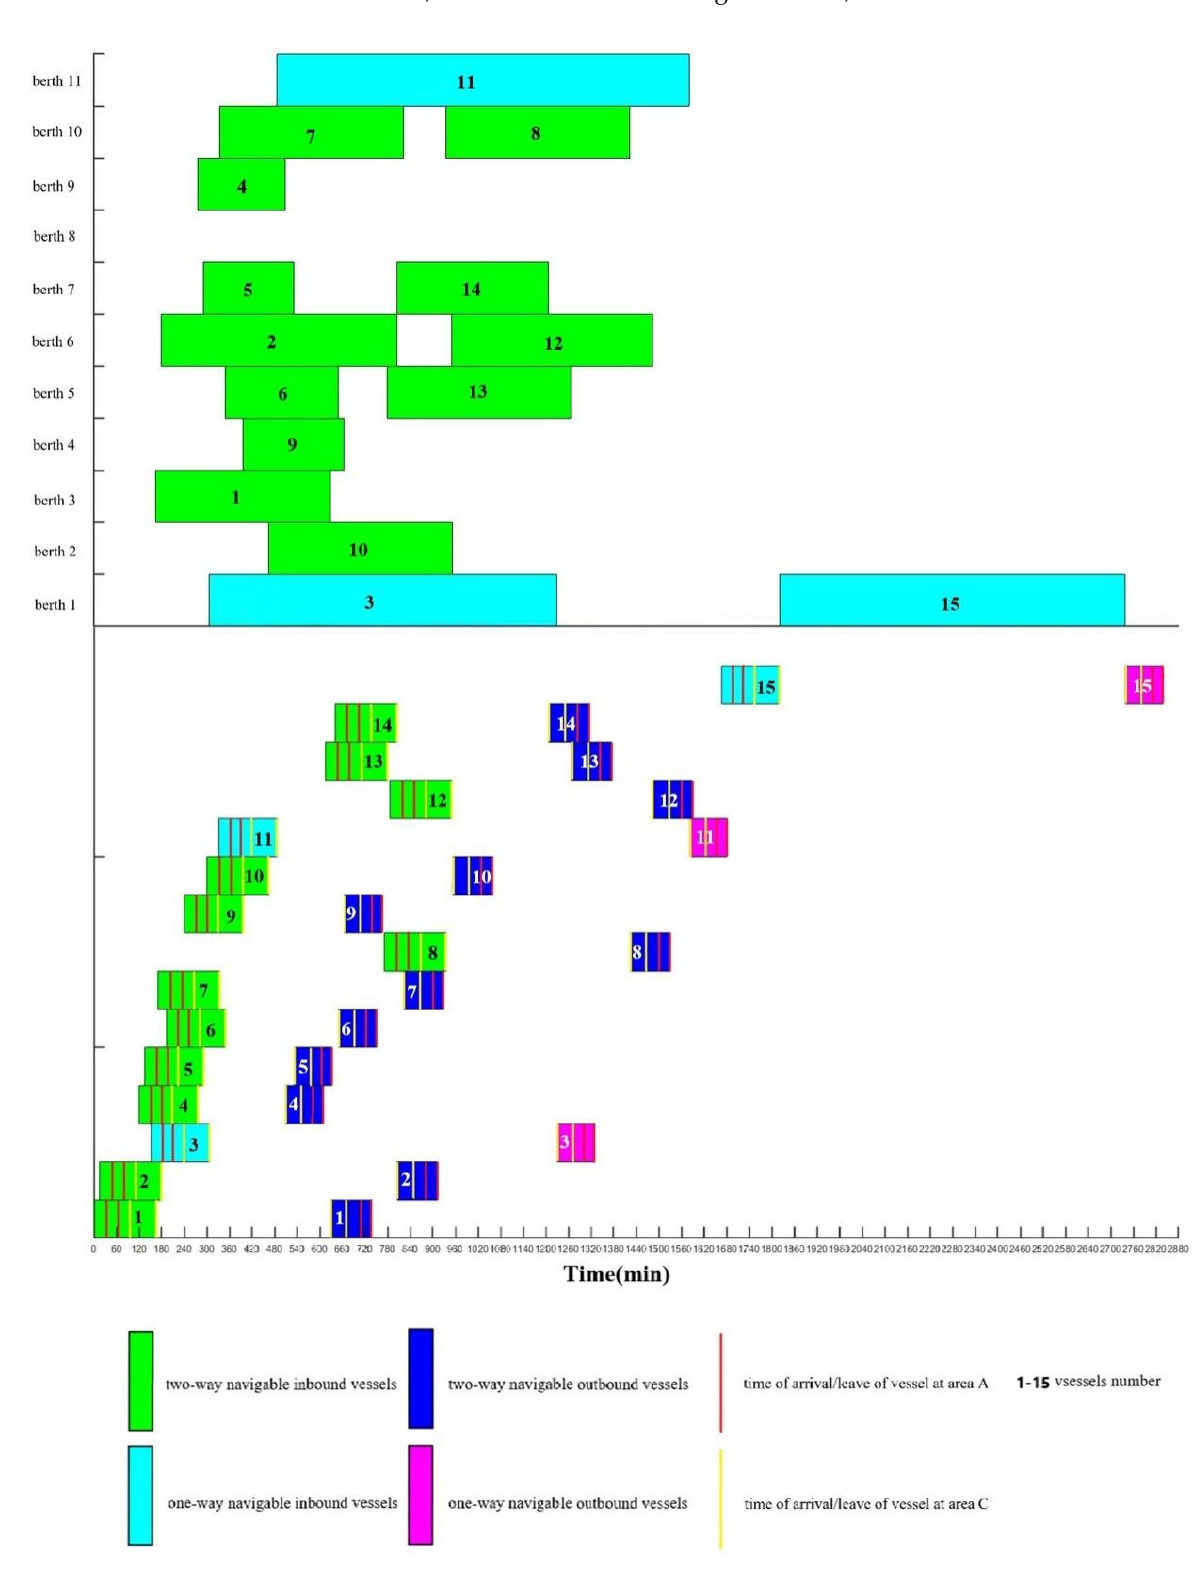
NSGA-II-DP algorithm to solve the proposed model conform to the navigation rules, which indicates that, in terms of time and navigation rules, the model constraints are reasonable.